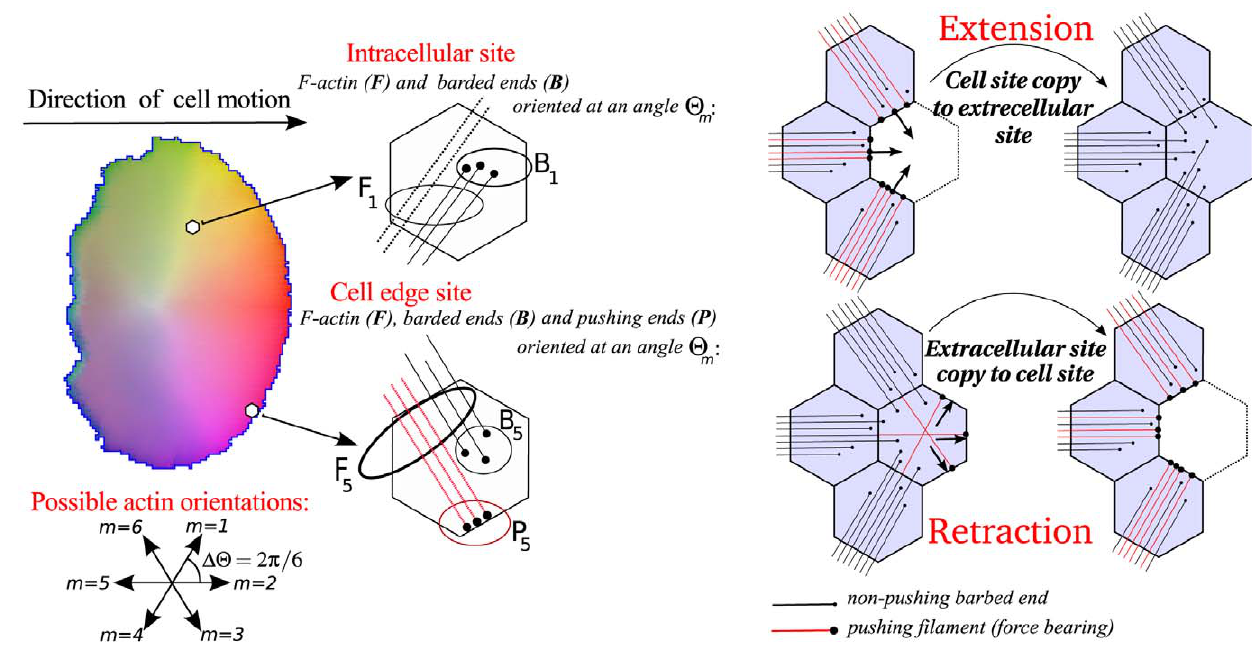
Figure 9. Membrane extensions and retractions. (left) Filament and barbed end densities are described at each grid point within the simulated cell (schematically shown by two representative hexagons), and for all possible orientations h m , shown at the bottom left. Additionally, close to the membrane we specifically distinguish between barbed ends that have not (yet) reached the membrane ( B ) and barbed ends that are effectively pushing against the membrane ( P ), thereby contributing to the forces required for cell extension. (right) The CPM allows for cell shape changes and movement through updates corresponding to small site extensions and retractions. Here, these updates take into account the density of pushing barbed ends. When the cell extends, the pushing barbed ends increase the likelihood of extension (top right – note that all red filaments end up with a pushing barbed end and therefore contribute to the forward motion), while during retraction the barbed ends offer resistence, reducing the likelihood of retraction (bottom right – also note that many black (non force-bearing) filaments are promoted to red (force-bearing) filaments when the retraction is accepted).